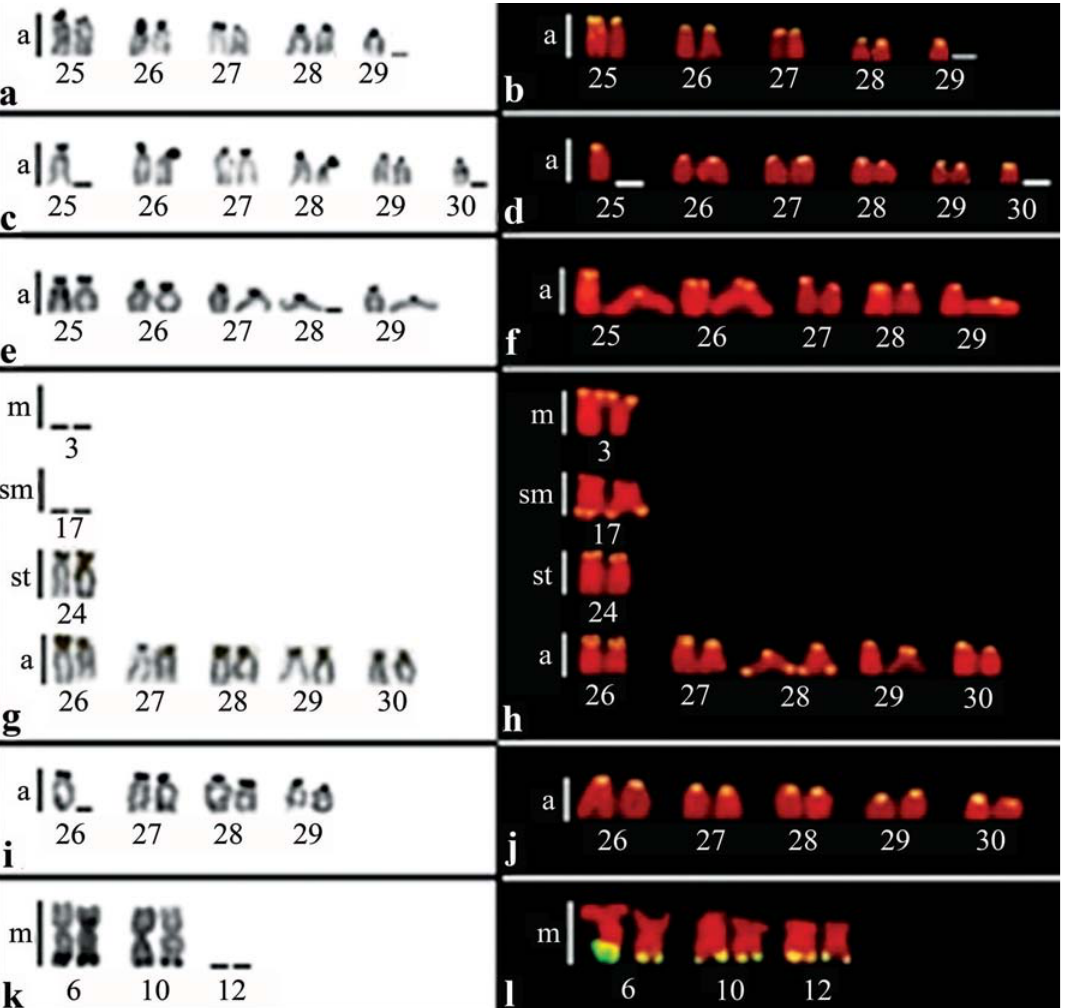
Fig. 2. Partial karyotypes of Serrasalmidae species showing Ag-NORs (left side) and 18S rDNA sites (right side): a-b ) Serrasalmus elongatus ; c-d ) Serrasalmus maculatus ; e-f ) Serrasalmus cf. rhombeus ; g-h ) Serrasalmus rhombeus ; i-j ) Pygocentrus nattereri ; k-l ) Colossoma macropomum . Numbers indicate the corresponding chromosome pairs in the karyotypes of the